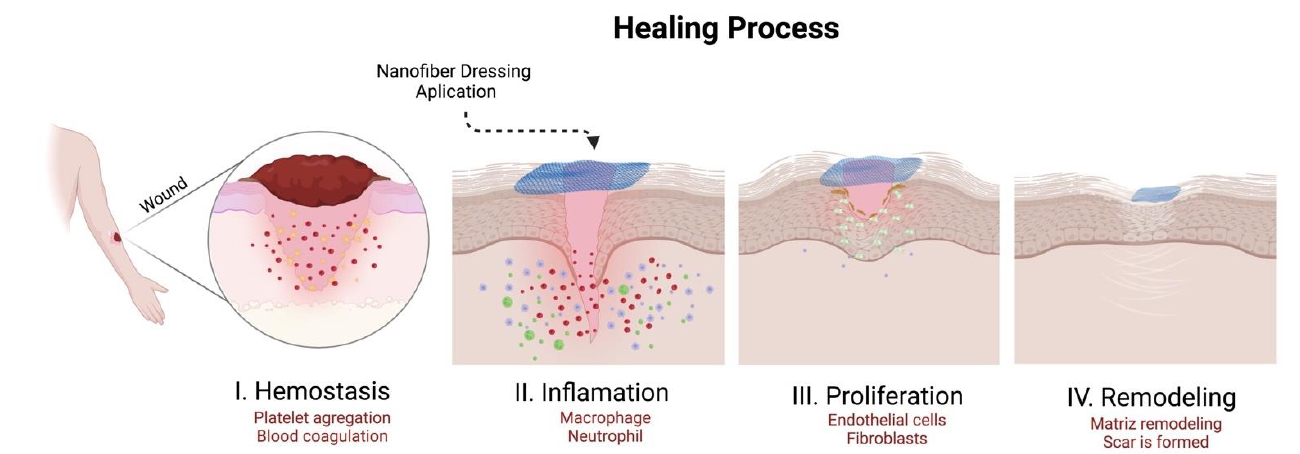
Figure 1. Scheme of the wound dressing action in the healing process (own drawing).